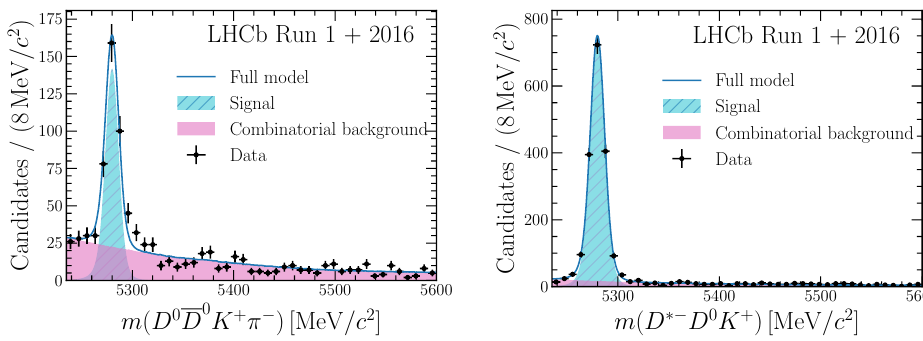
Figure 3: Invariant-mass distributions and fit projections for B 0 candidates in (left) the signal and (right) control mode for all subsamples combined. The small single- charm and charmless background is included in the signal